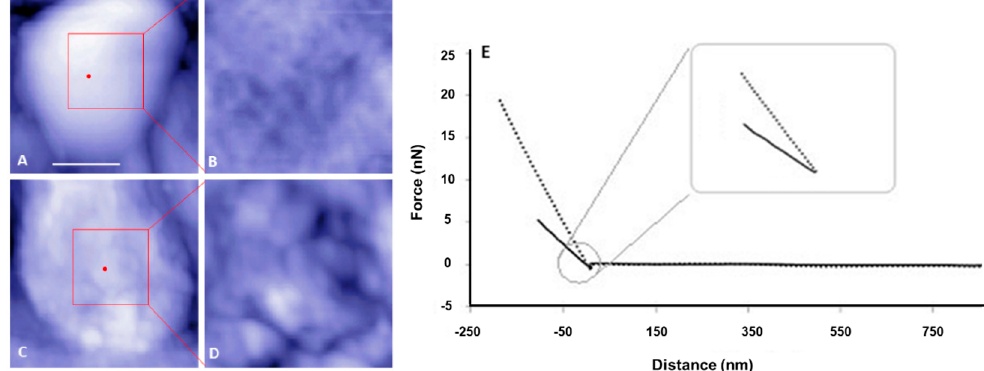
Figure 1. Representative atomic force microscopy (AFM) topography images and corresponding force curves of live Rhizobium leguminosarum bv. viciae 3841 (wild type, top row) and 3845 ( ctpA mutant, bottom row). Shown are low ( A , C ) and high ( B , D ) resolution AFM images of the live wild type ( A , B ) and ctpA mutant ( C , D ) rhizobia. Bar for A and C is 500 nm. Red dots on A, C indicate the approximate locations at the top center of the live cells, for collecting corresponding force approach curves ( E ) with solid (wild type) and dashed ( ctpA mutant) lines, and subsequent creep experiments.